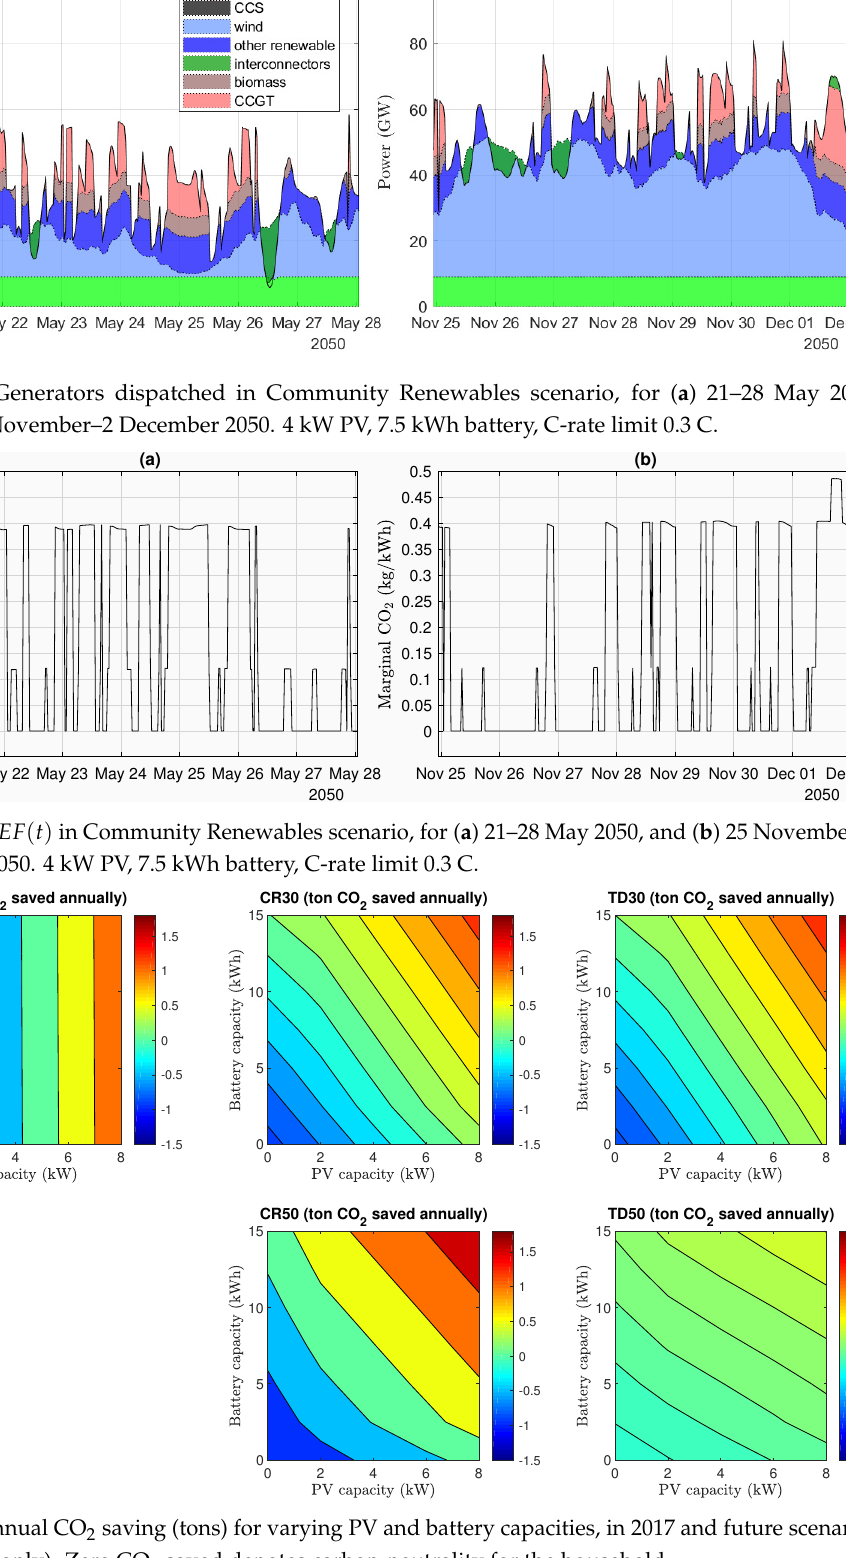
Figure 9. Annual CO 2 saving (tons) for varying PV and battery capacities, in 2017 and future scenarios ( n th system only). Zero CO 2 saved denotes carbon-neutrality for the